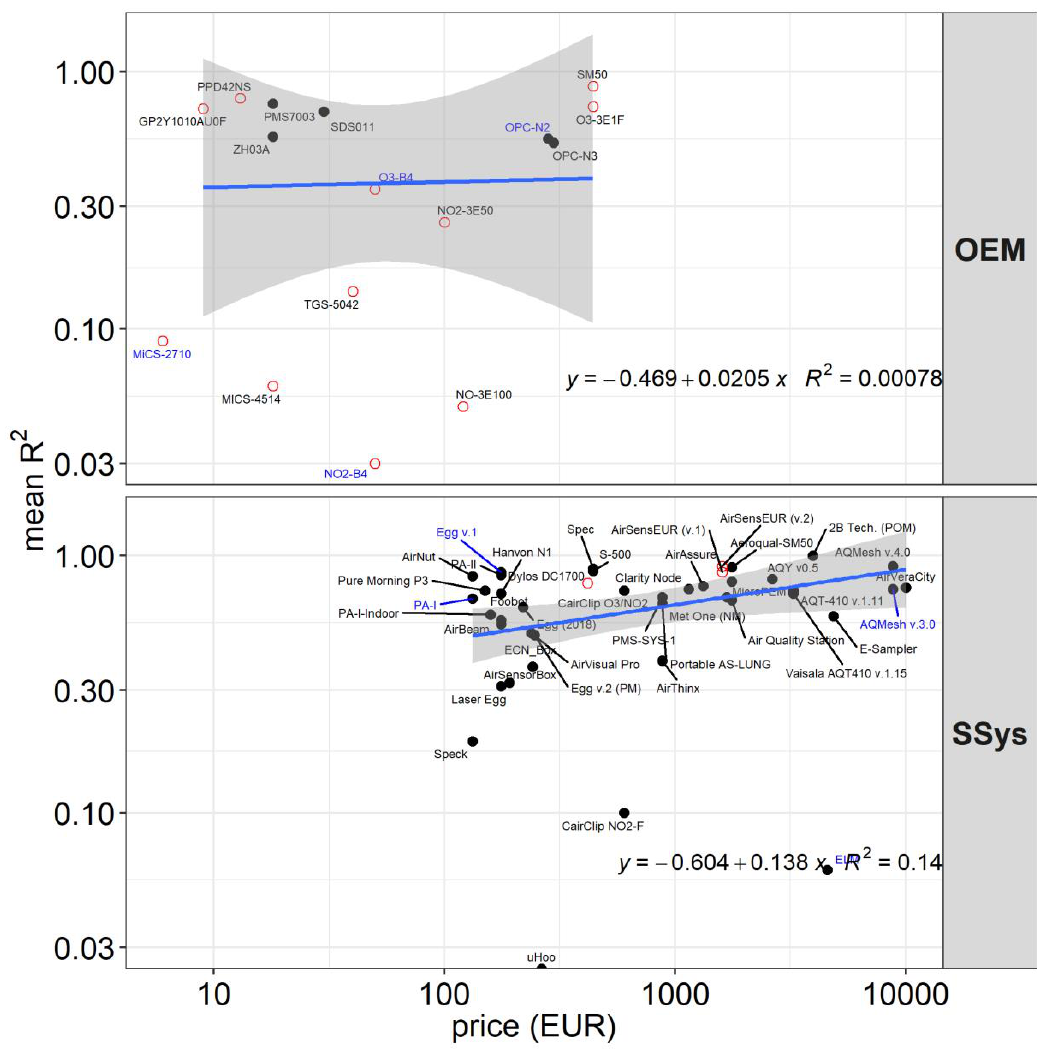
Figure 7. Relationship between prices of LCS and R 2 for field test only. A logarithmic scale has been set for both axes. Open source and black box models are indicated with red open dots and black solid dots, respectively. Names of “living” and “non-living” sensors are indicated by black and blue colors, respectively. R 2 refers to data averaged over 1 h. Grey shade in the fit plots indicate a pointwise 95% confidence interval on the fitted values.